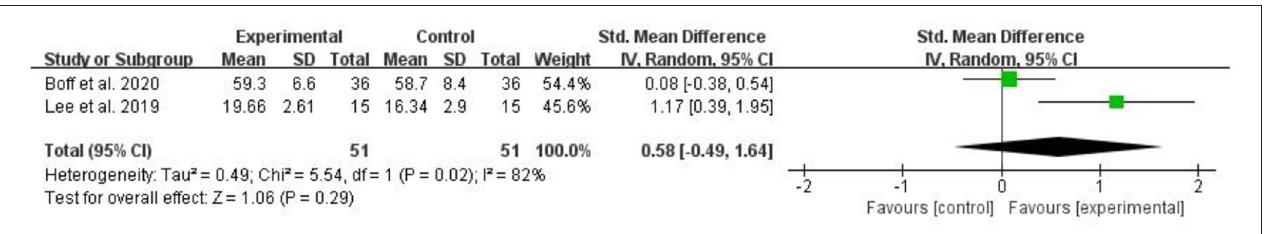
dynamic characteristics of the human body (39). Fascial tissue hardening or increased tension and decreased sliding ability may be the cause of tension in other parts of the body, which in turn leads to increased pain and limited function